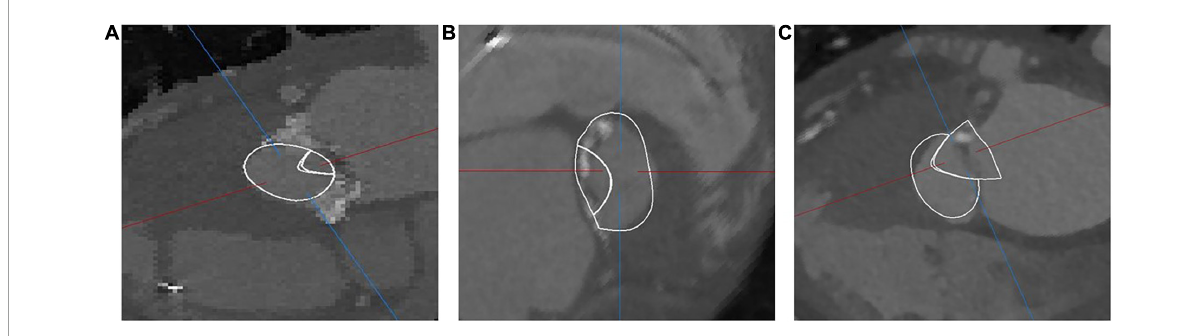
FIGURE2 Overlay of computational domain onto CT depicting the shape of the neo-LVOT in VIM-1 (A) , VIM-2 (B) , and VIM-3 (C) .